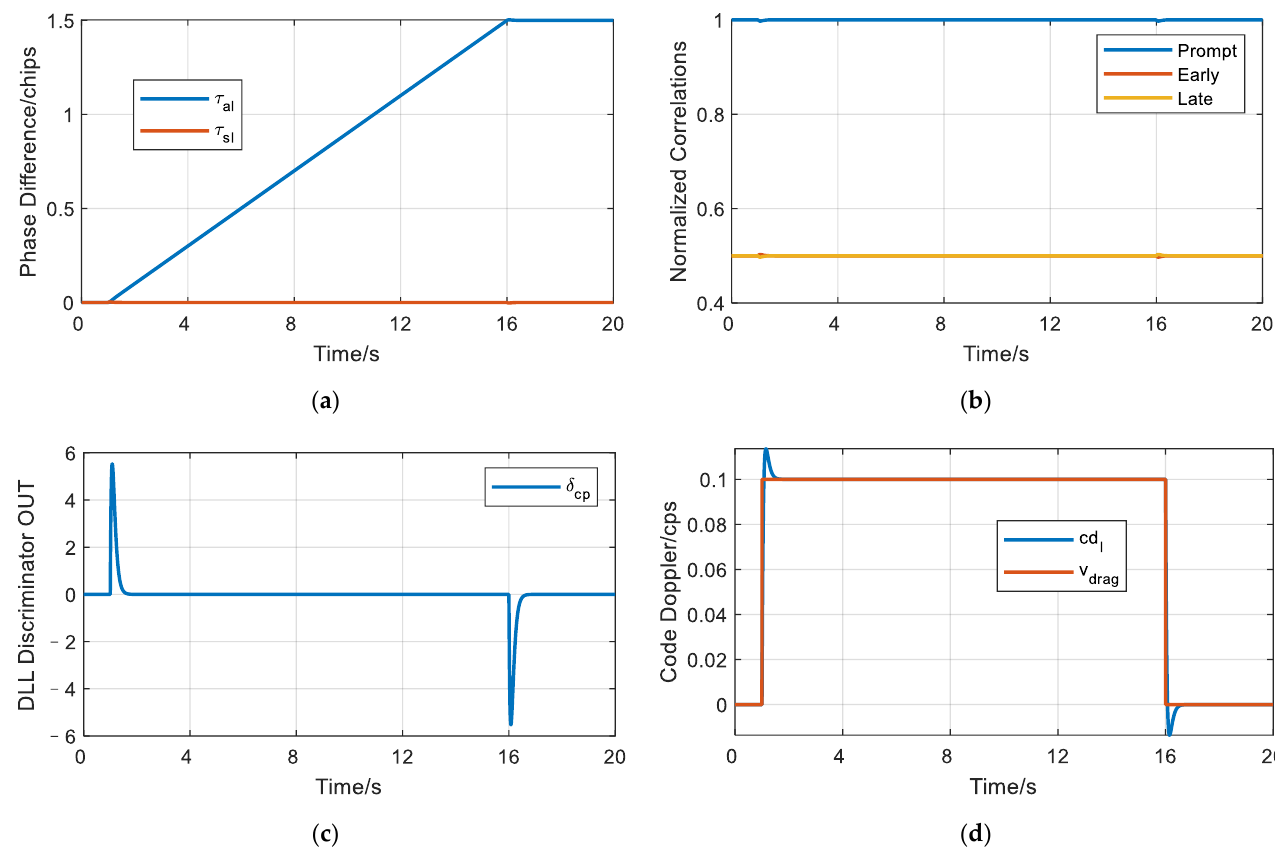
Figure 13. Theoretical simulation results of the proposed traction strategy. ( a ) Code phase difference; ( b ) Outputs of correlators; ( c ) Outputs of phase discriminator of code tracking loop; ( d ) Outputs of filter of code tracking loop. Table 3. Value ranges of v drag for three strategies.